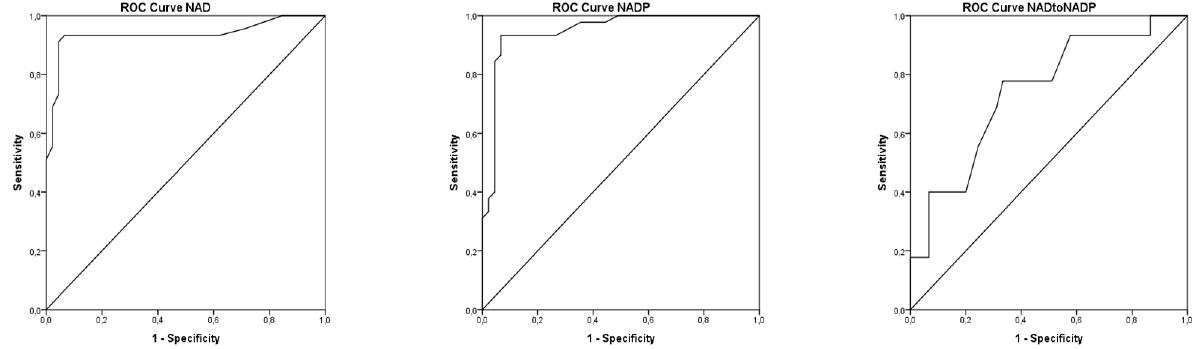
Figure 1. ROC curve for niacin status indicators NAD, NADP and NAD:NADP for distinguishing cows that received and did not receive additional niacin in food.